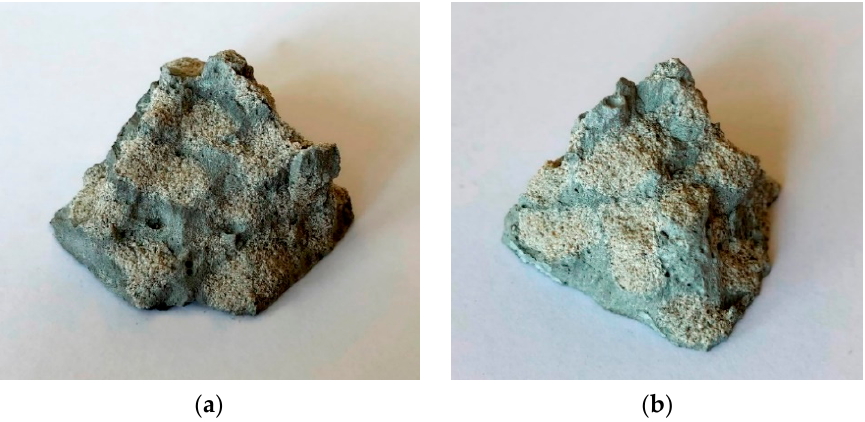
Figure 3. Appearance of the surfaces of chipped specimen cubes: ( a ) 0.63 + 10% CB-2 and ( b ) 0.63 + 15% CB-2.